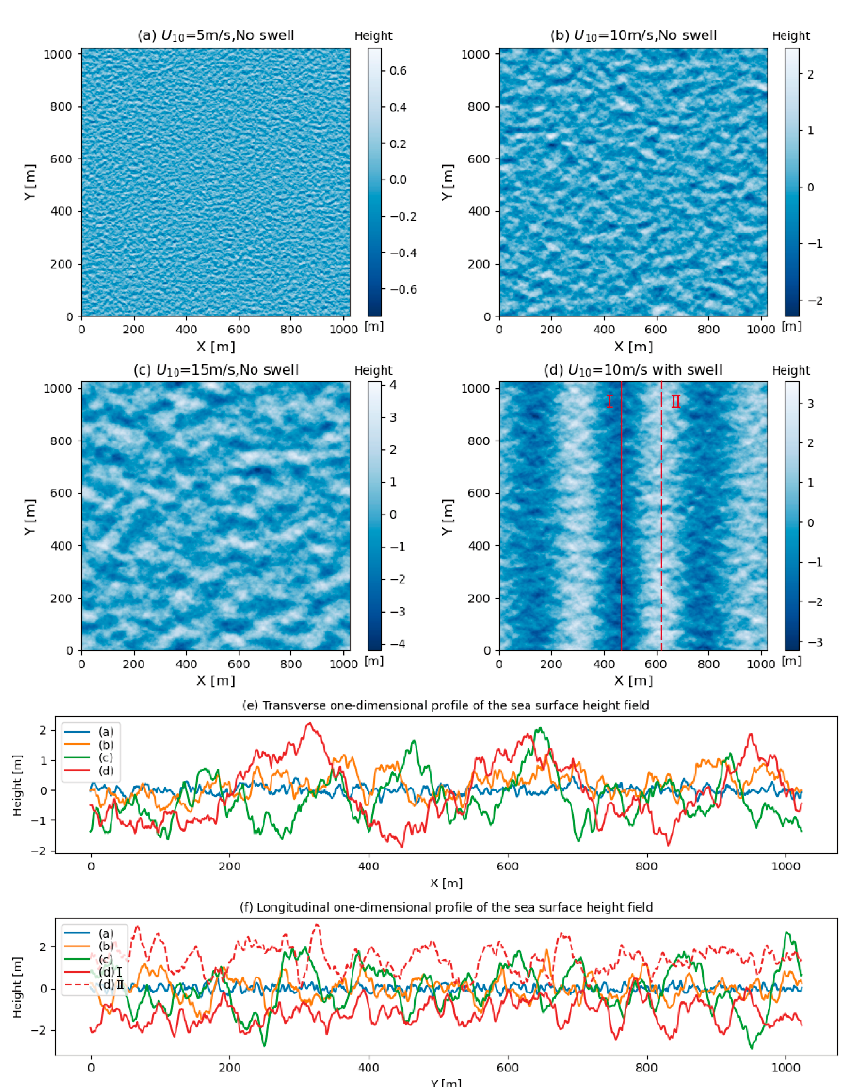
Figure 4. Field of sea surface heights under various sea conditions. ( a – c ) represent the sea surface without swell at low wind speed (U = 5 m/s), medium wind speed (U = 10 m/s), and high wind speed (U = 15 m/s), respectively. ( d ) is a scene with swell on the sea surface and a medium wind speed, with a swell wavelength of about 300 m and an effective wave height of 2 m. ( e ) is transverse one-dimensional profile of ( a – d ). ( f ) is longitudinal one-dimensional profile of ( a – d ). The line I is the profile line at the trough of the swell, and the line II is the profile line at the crest of the swell. Because of the small incidence angle, backscattering at the sea surface is mainly dominated by specular scattering. Therefore, we calculated sea surface backscattering using the Kirchhoff approximation and SPA (as shown in Equation (5)) [45]. Figure 5 shows instantaneous backscattering coefficients for specular scattering. The backscattering energy at the sea surface at an incidence angle of 6 ◦ is larger than that at 12 ◦ . At 12 ◦ , scattering mainly occurs on the upslope surface of swell-induced undulations (facing the radar side). The number of specular scattering points at 12 ◦ is much smaller than that at 6 ◦ . There is little difference between the backscatter of VV polarization and that of HH